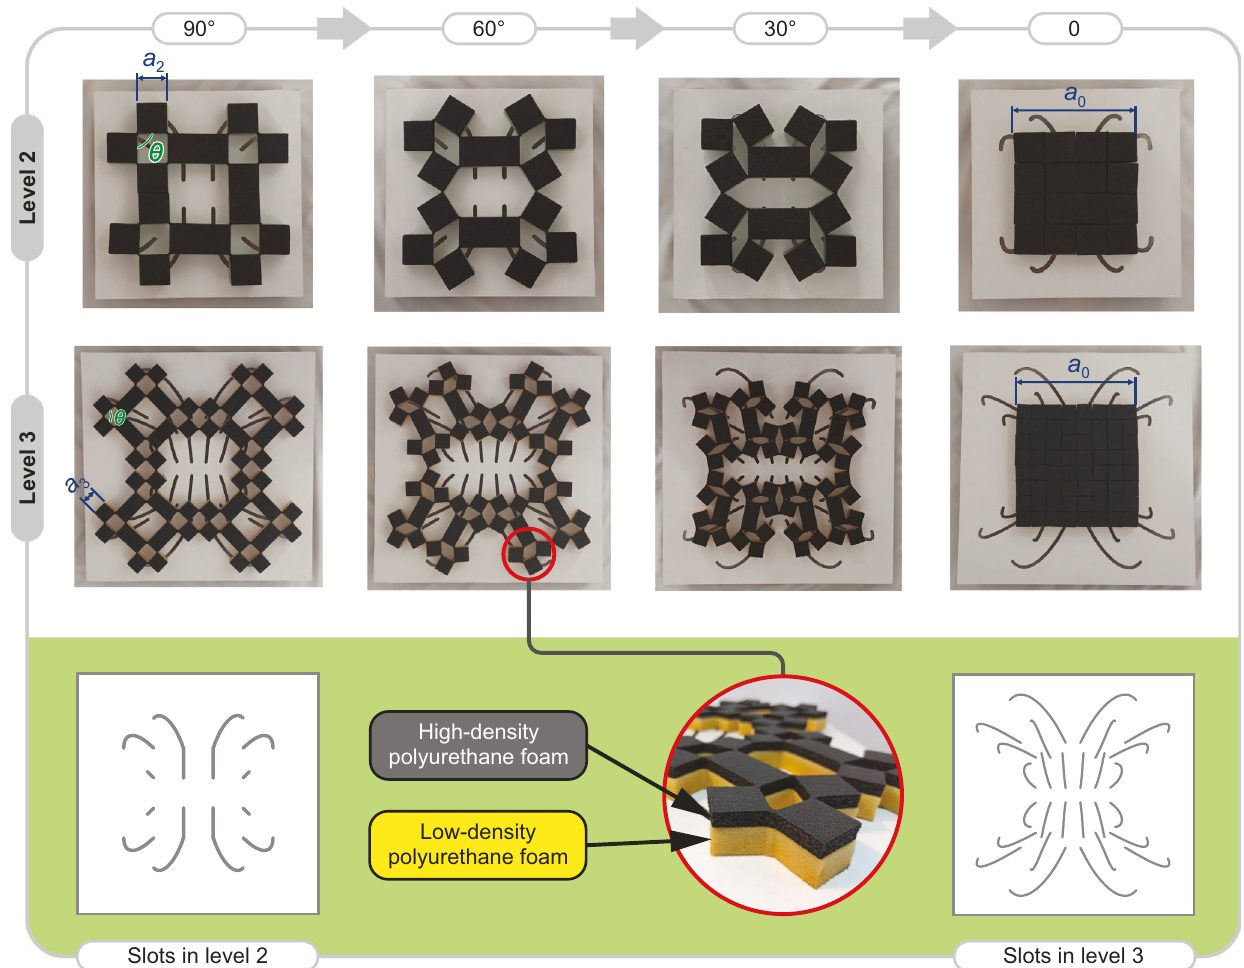
Fig. 7 Contraction of physical models made of polyurethane (PU) foams for the ENAs of levels 2 and 3. The models are depicted in the particular deployment angles of 90°, 60°, 30°, and